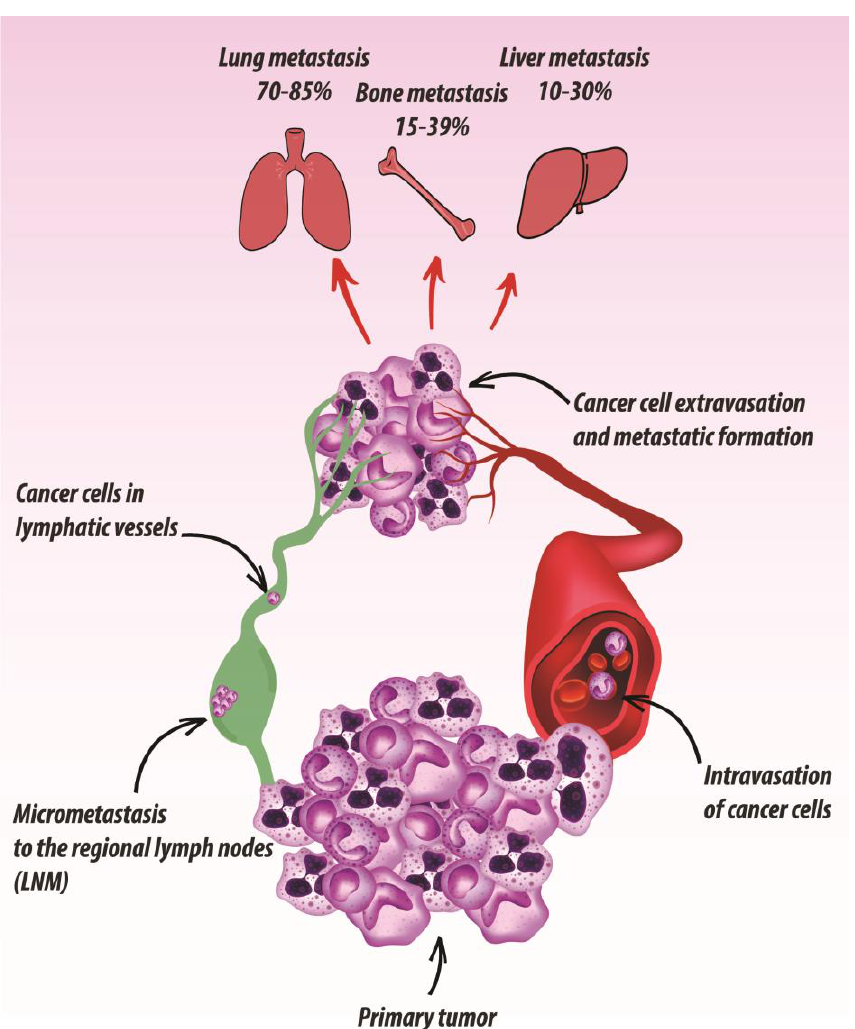
Figure 1. Schematic drawing of the metastatic spreading of UADT SCC.SCC tumor cells from the primary site penetrate the lymphatic vessels thus migrating to the regional lymph nodes forming Lymph Node Metastasis (LNM). Metastasis of SCC cells to the distant organs occurs both through the lymphatic and blood vessels mainly leading to lung, bone and liver colonization.